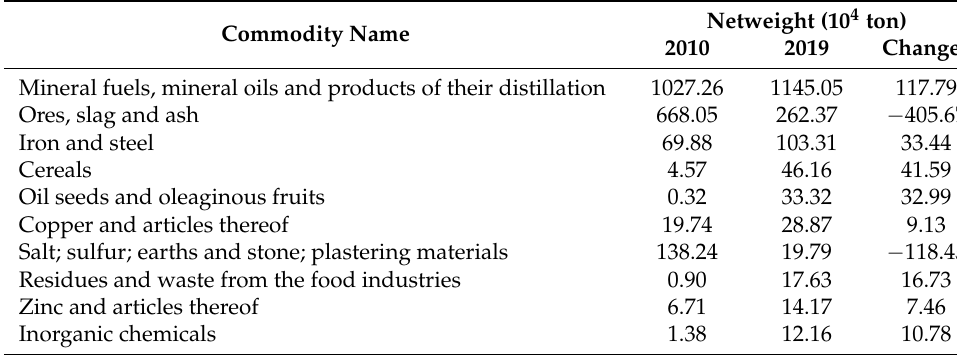
Table 8. Comparison of the top 10 bulk commodities exported from the CANs to China before (2010) and after (2019) the